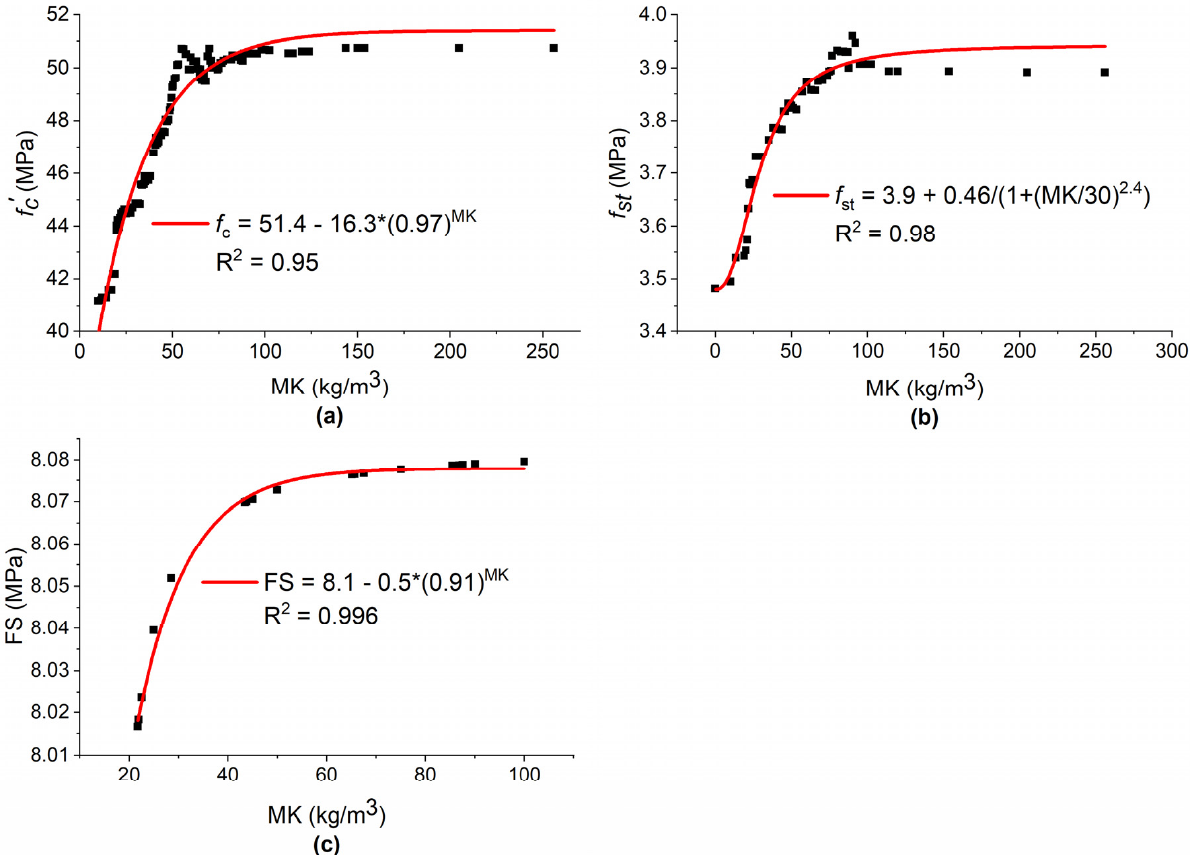
Figure 25. Variation in mechanical properties of concrete with MK: ( a ) (cid:1858)′ (cid:2913) ; ( b ) (cid:1858) (cid:2929)(cid:2930) ; ( c ) FS